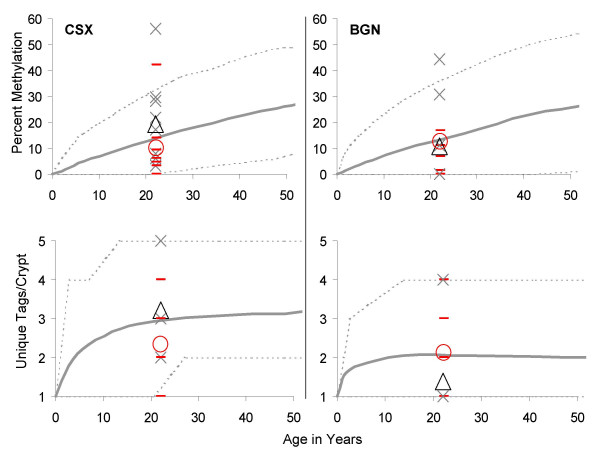
Crypt methylation tags are consistent with a clock-like stochastic accumulation of methylation errors from birth. Such a model using previously published crypt parameters [4] can be simulated on a computer to yield expected individual (dotted lines include 95% of simulated crypt outcomes) and average (solid grey line) crypt values. Little difference is expected between the initial (black X 's are individual crypt values and black triangles are average values) and final specimens (red bars are individual crypt values and red circles are average values) because by this model, methylation errors slowly accumulate from birth, and few additional changes are expected to accumulate during the 62 days between specimens.